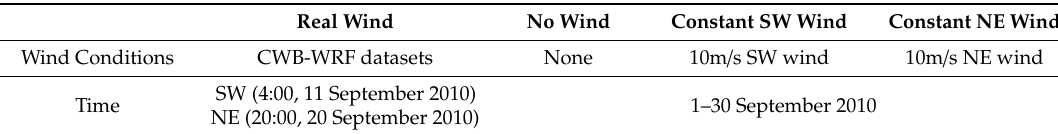
Table 2. The wind conditions in this